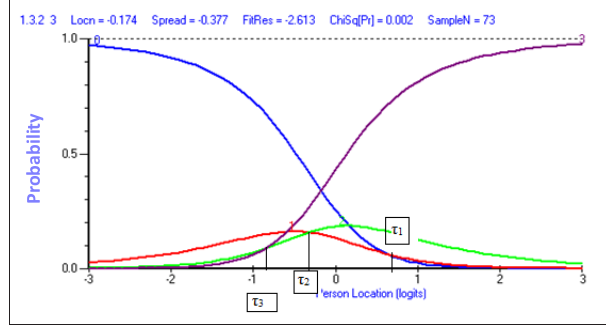
FIGURE 10: Initial category probably curves for Item 1.3.2.